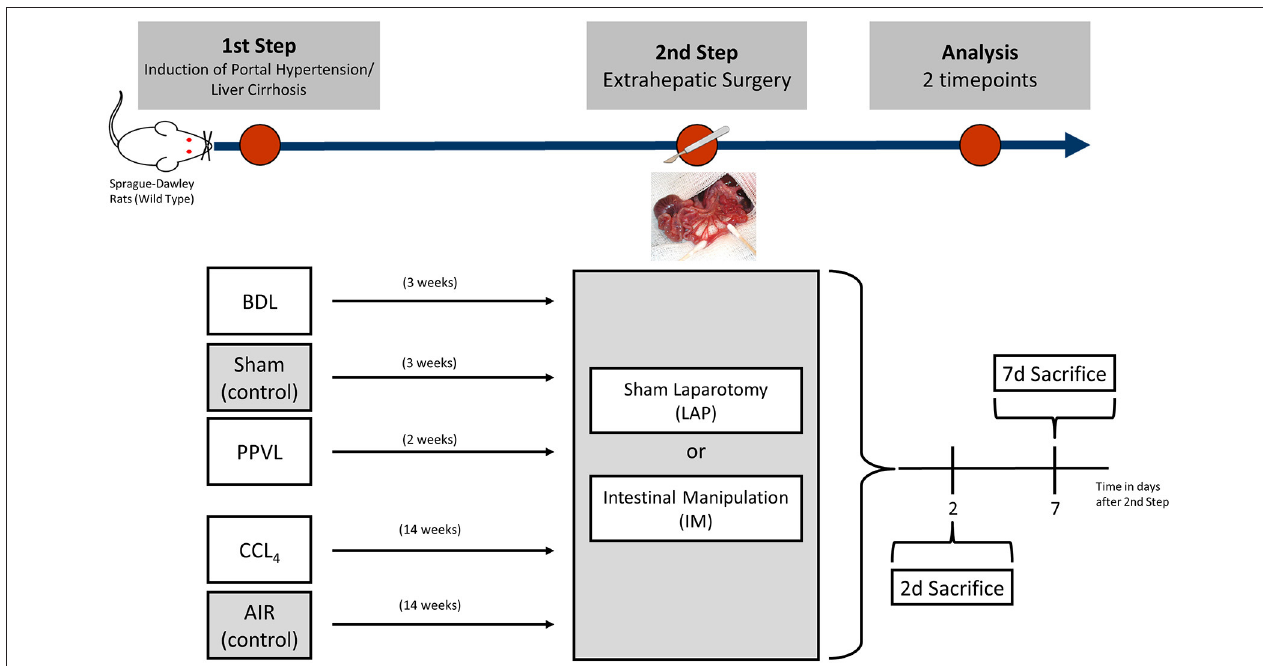
FIGURE 1 | Diagram showing how a two-step pre-clinical model of extrahepatic abdominal surgery (intestinal manipulation) in Sprague-Dawley rats with cirrhosis induced through bile duct ligation (BDL) or inhalation of tetrachlormethan (CCL4) and non-cirrhotic portal hypertension via partial portal vein ligation (PPVL) was established with two timepoints of final